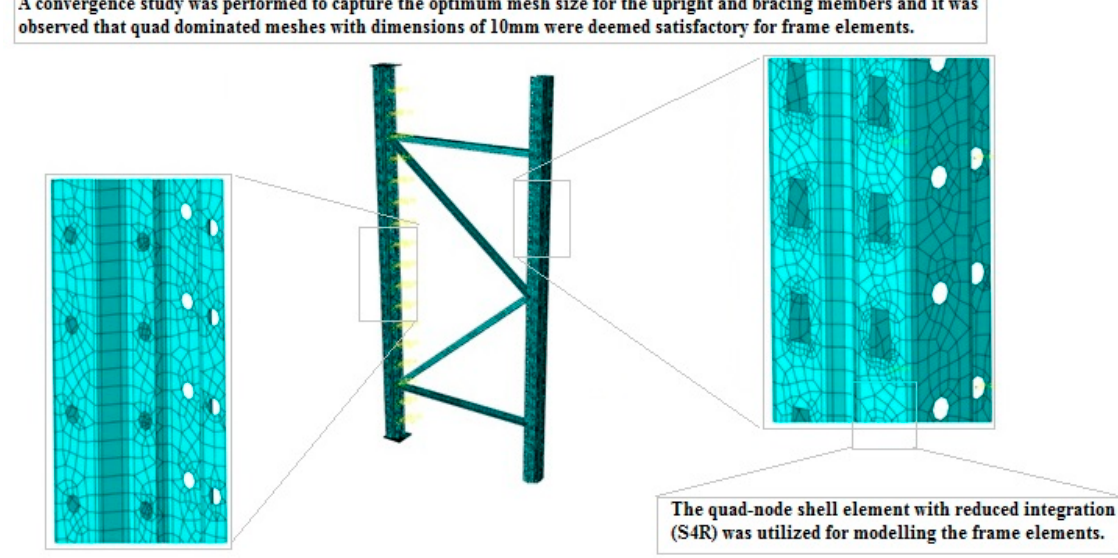
Figure 6. A typical model with a mesh matrix view on the polygon and circular perforations.